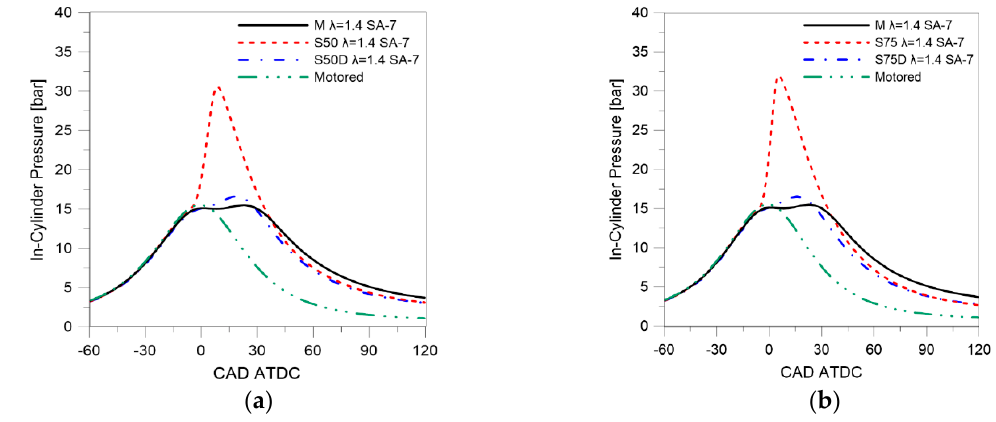
Figure 6. In-cylinder pressure traces averaged for lean fuelling ( λ = 1.4) for: ( a ) 50% H 2 blends and ( b ) 75% H 2 blends, compared with methane. Table 4. Mass fraction burned position for combustion ignition, kernel development and main phase with respect to the start of spark.